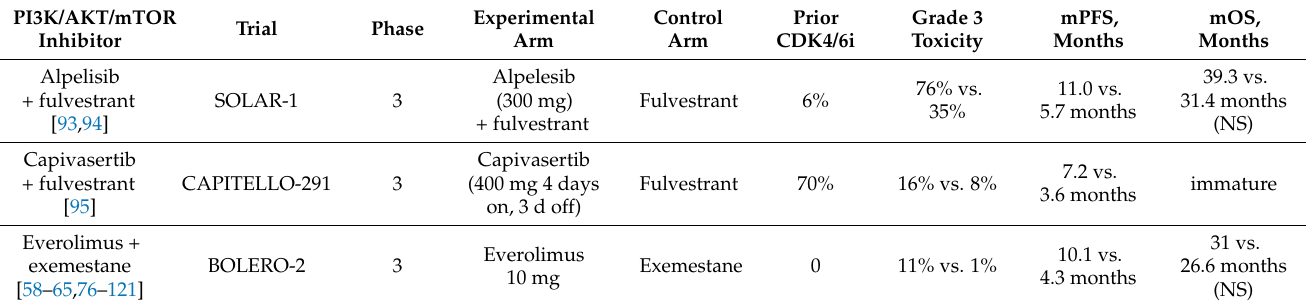
Table 3. Positive studies of PI3K/AKT/mTOR